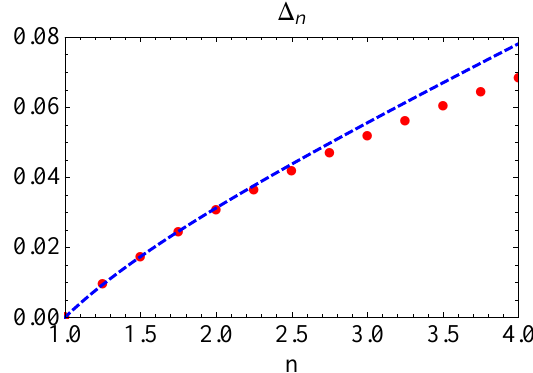
(cid:0) (cid:1) = 1 n − 1 (dashed line) compared to values of ∆ n n 48